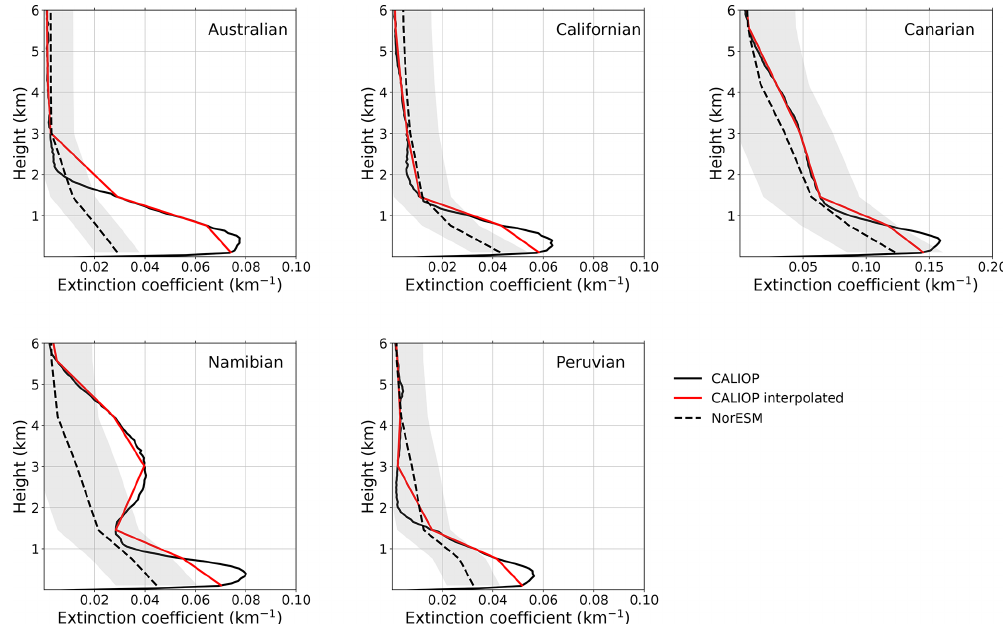
Figure 2. Vertical distribution of the total aerosol extinction coefficient (km − 1 ) for CALIOP data from 2007 to 2016 for the Australian, Californian, Canarian, Namibian, and Peruvian regions (solid black line). The CALIOP vertical levels were interpolated to the corresponding model levels (solid red line). In addition, the model control simulation averaged over 10 years is shown (dashed line) with the SD (grey shaded